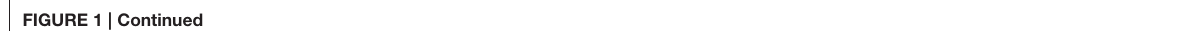
of translation-dependent postsynaptic function seems